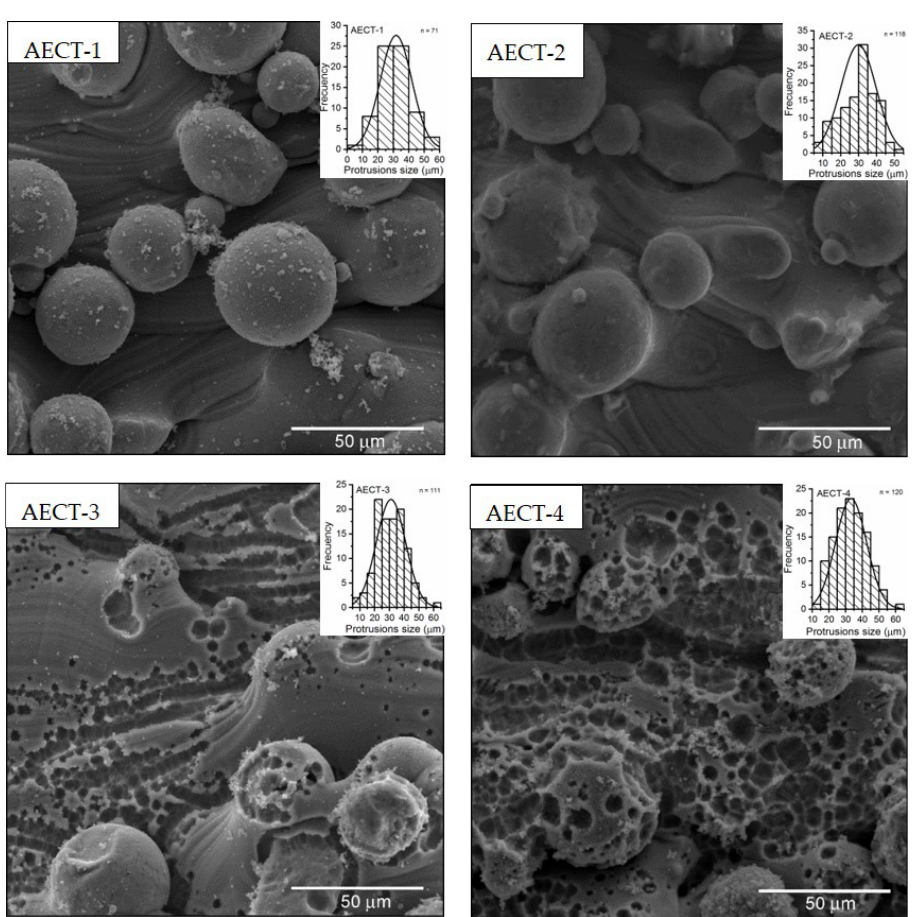
Figure 4. SEM micrographs AECT surfaces at low magnification and protrusions size distribution on AECT surfaces.